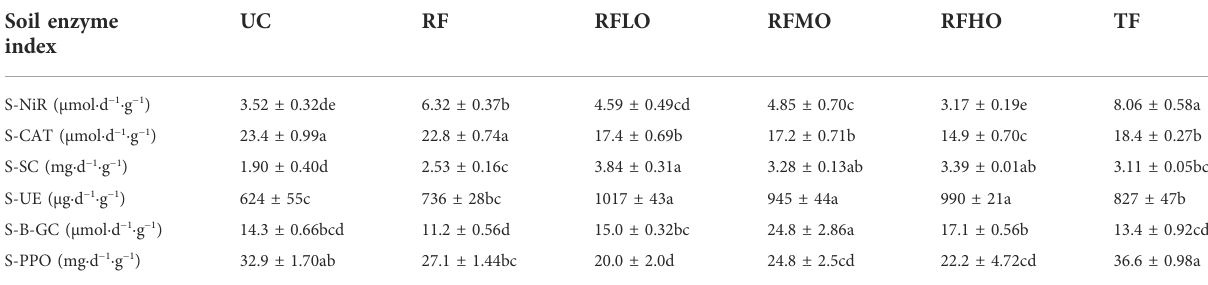
TABLE 5 Soil enzyme variables under each soil fertilizer management practice at 0 – 20 cm soil depth. Soil enzyme